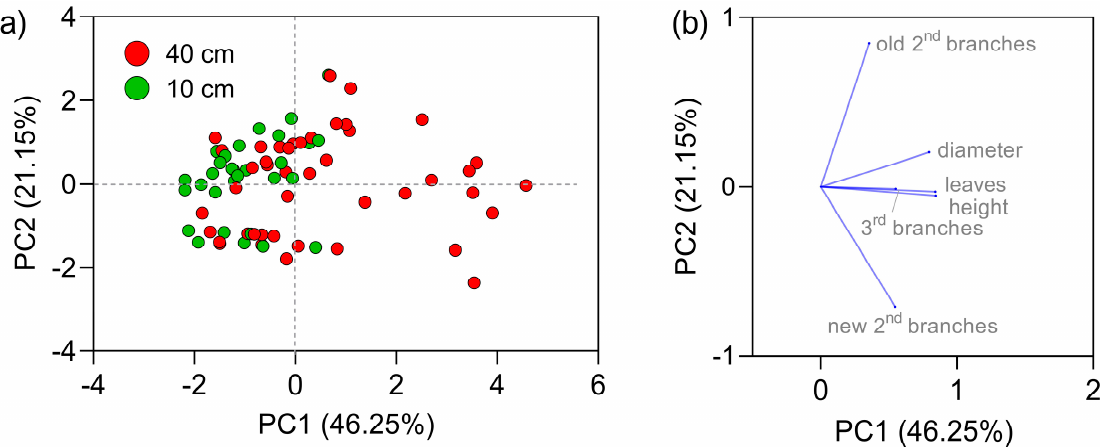
Figure 9. ( a ) Distribution in the hyperspace of the scores of the first two components of the data collected in 2020/Nov according to their morphological development. ( b ) Vector-correlation plot among the variables examined. The variables analyzed were the number of old and new secondary branches, diameter and number of leaves of old branches, and number of tertiary branches.